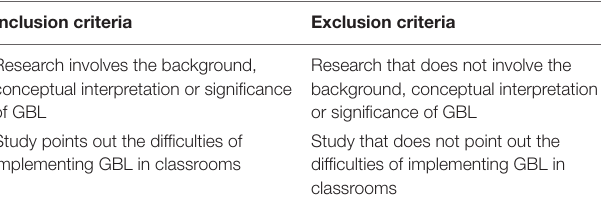
TABLE 1 | Selection criteria in the second